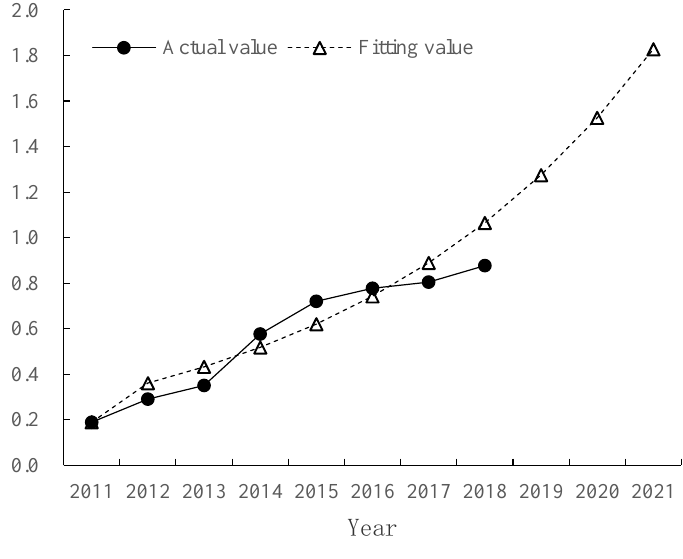
Figure 4. Comparison of actual value and predicted value of ecological security early-warning index in the Qinghai alpine agricultural mountainous area.